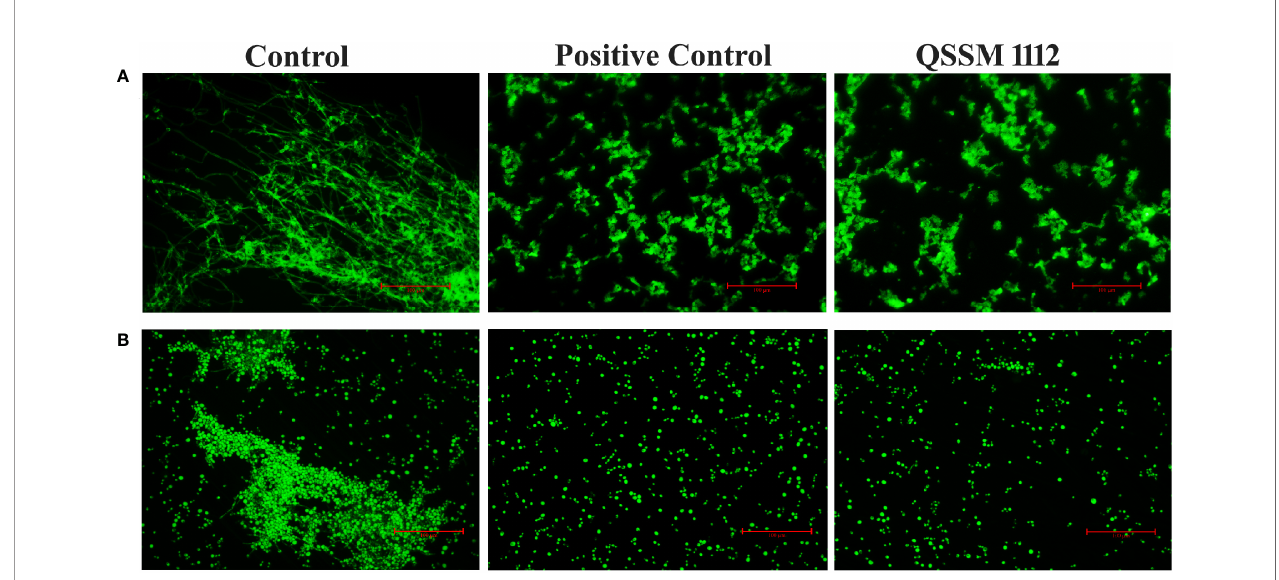
FIGURE 9 | Fluorescence microscopic observation showcases the inhibitory potential of QSSM 1112 on (A) yeast-to-hyphal transition (B) germ-tube formation of Candida albicans